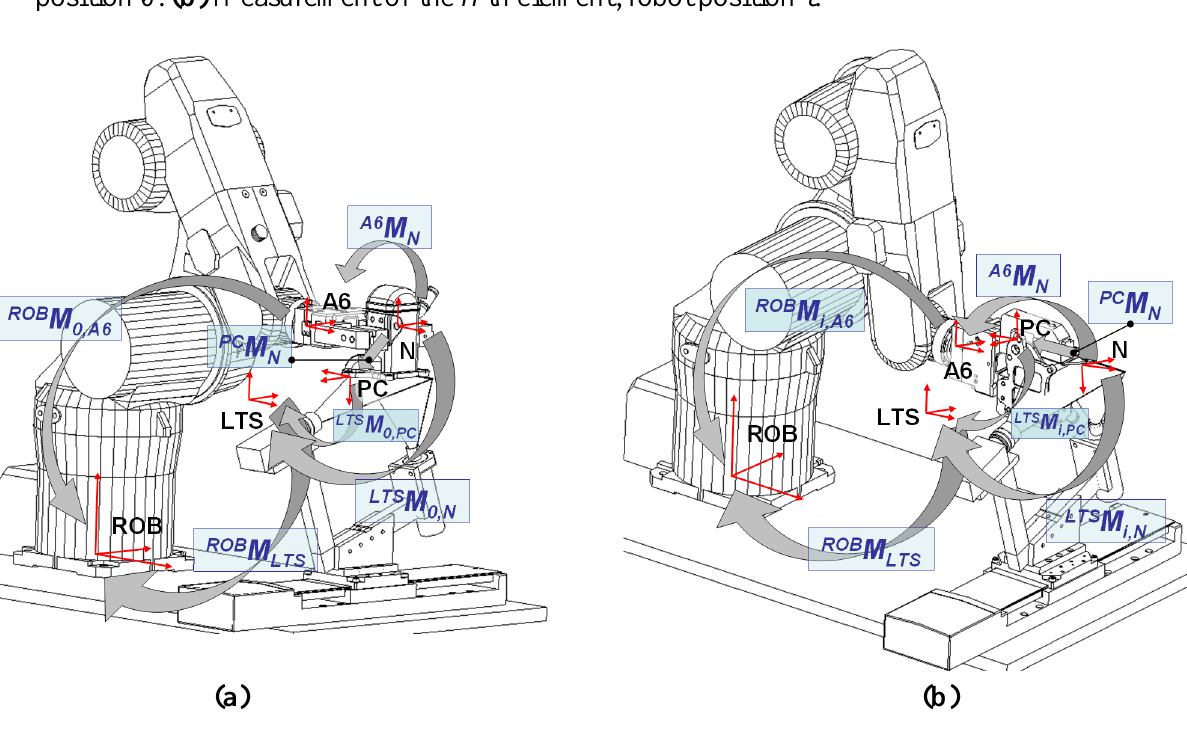
Figure 13. Principal frames and transformation matrices used in the proposed model. The same pattern is applied to the serial piece substituting PC with pc & N with n. (a) Measurement of the element that materializes the global frame of the part, robot position 0. (b) Measurement of the n -th element, robot position i